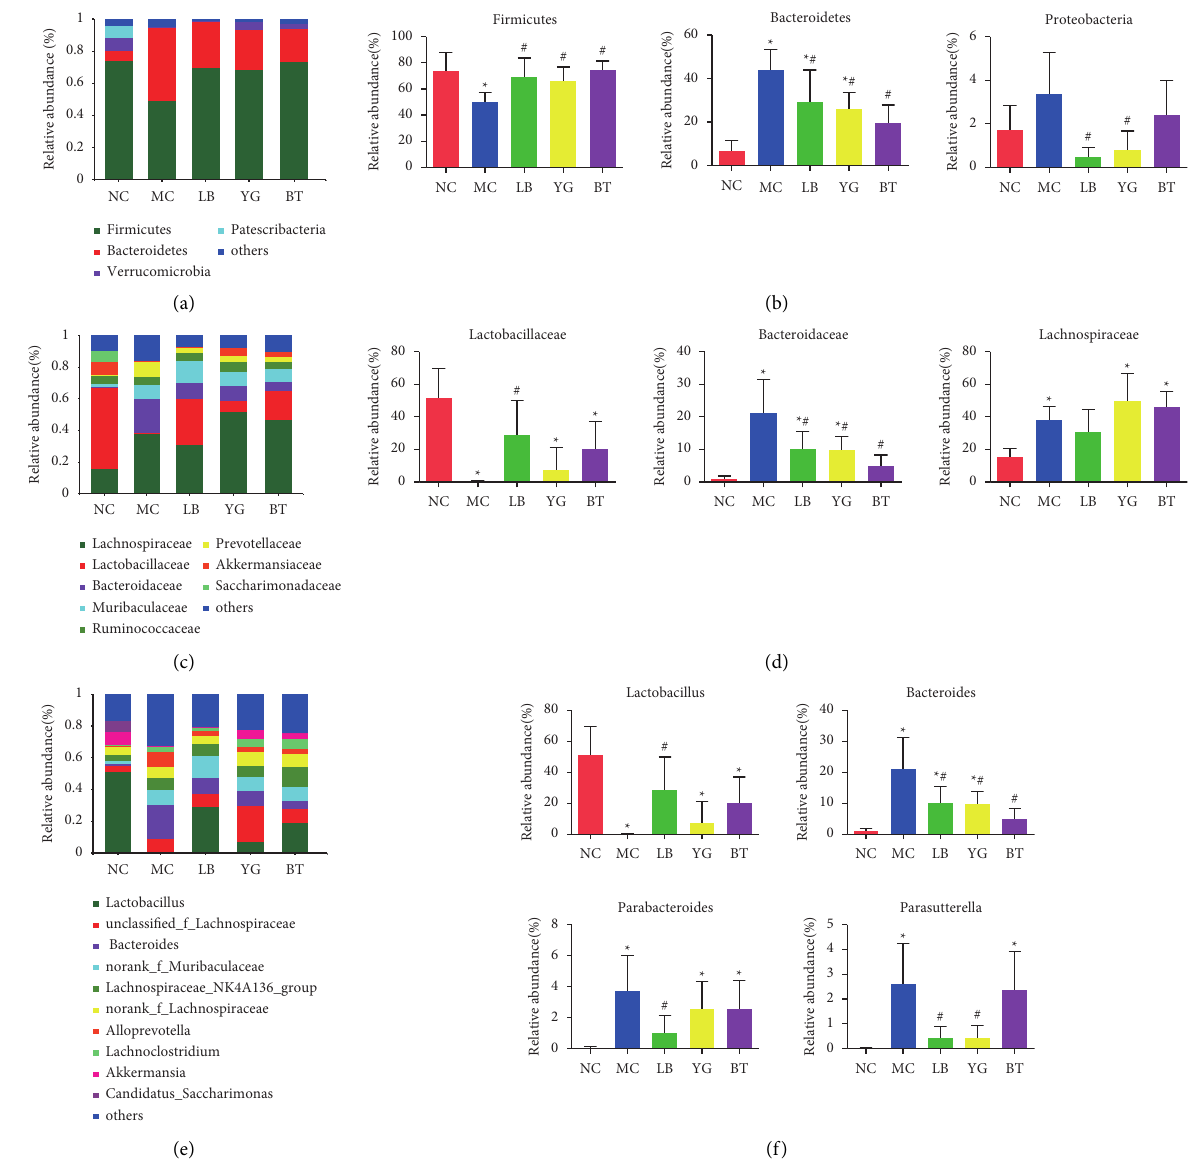
Figure 3: The composition of gut microbiota in different groups. (a) Phylum level; (b) main differences in compositions at the phylum level; (c) family level; (d) main differences in compositions at the family level; (e) genera level; (f) main differences in compositions at the genus level. NC, normal group; MC, model group; LB, Lacidophilin tablet group; YG, yogurt group; BT, bifid triple viable capsule group. Values are expressed as the mean ± SD. ∗ p < 0 . 05 compared with the normal group; # p < 0 . 05 compared with the model